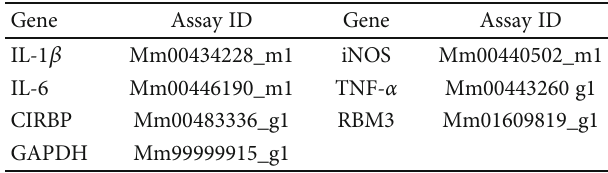
Table 1: TaqMan® Gene Expression Assays. Gene Assay